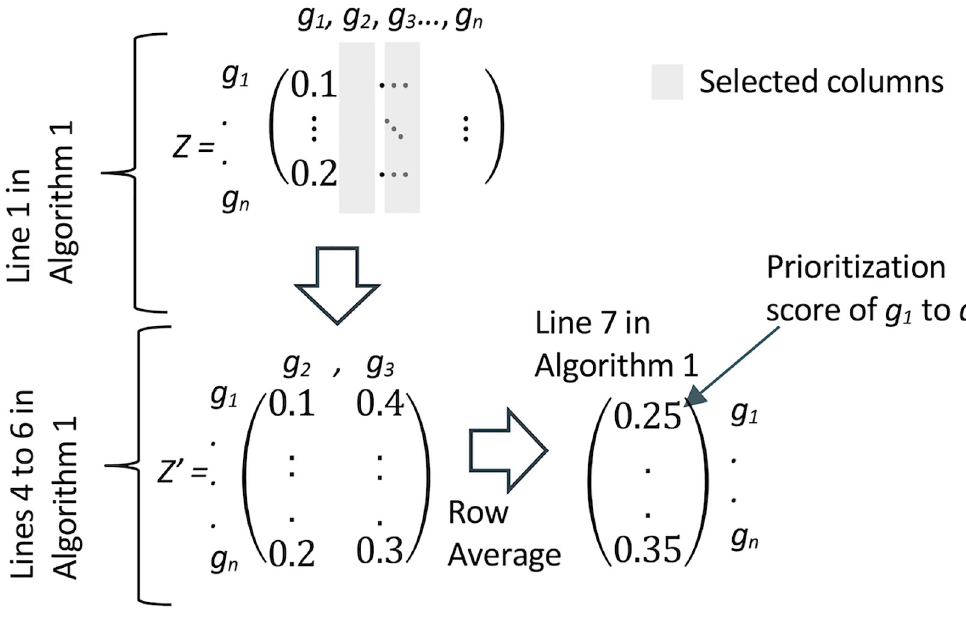
Fig 2. An illustrated example of Algorithm 1 (Fig 1). Z is a gene-gene co-expression similarity matrix. Line 1 in Algorithm 1: given disease d that is known to associate with genes g 2 and g 3 , columns 2 and 3 are selected in Z to create matrix Z 0 . Lines 4 to 6 in Algorithm 1: each row in Z 0 is averaged into a Gene-Disease Prioritization Score. The prioritization score of g 1 for d is (0.1+0.4)/2 = 0.25, reflecting the average similarity of a non-associated gene g 1 to genes associated with d .